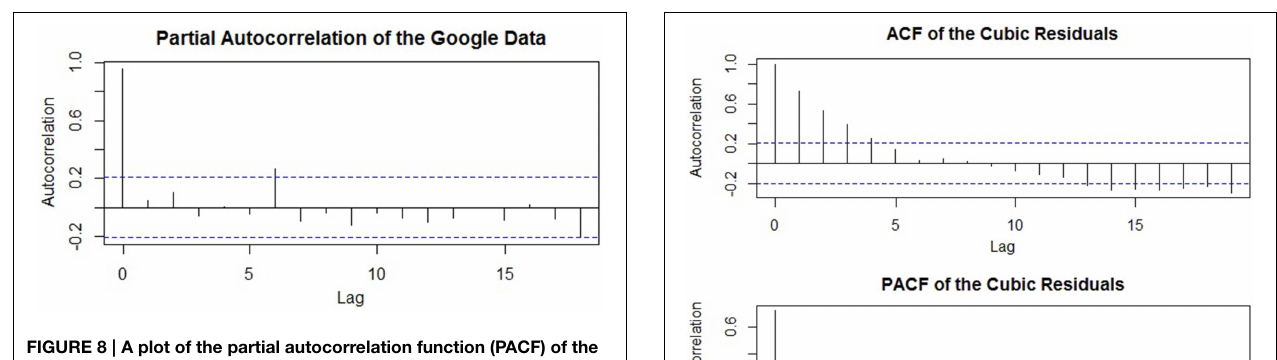
FIGURE 8 | A plot of the partial autocorrelation function (PACF) of the seasonally adjusted time series of Google job searches.